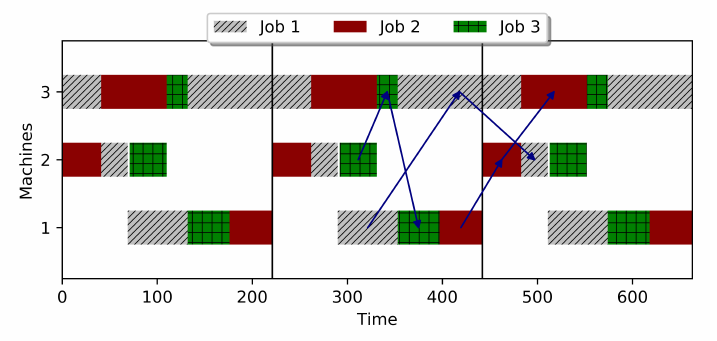
Figure 5. The Gantt chart of three consecutive cycles for the problem instance in Table 1; blocking CJSS